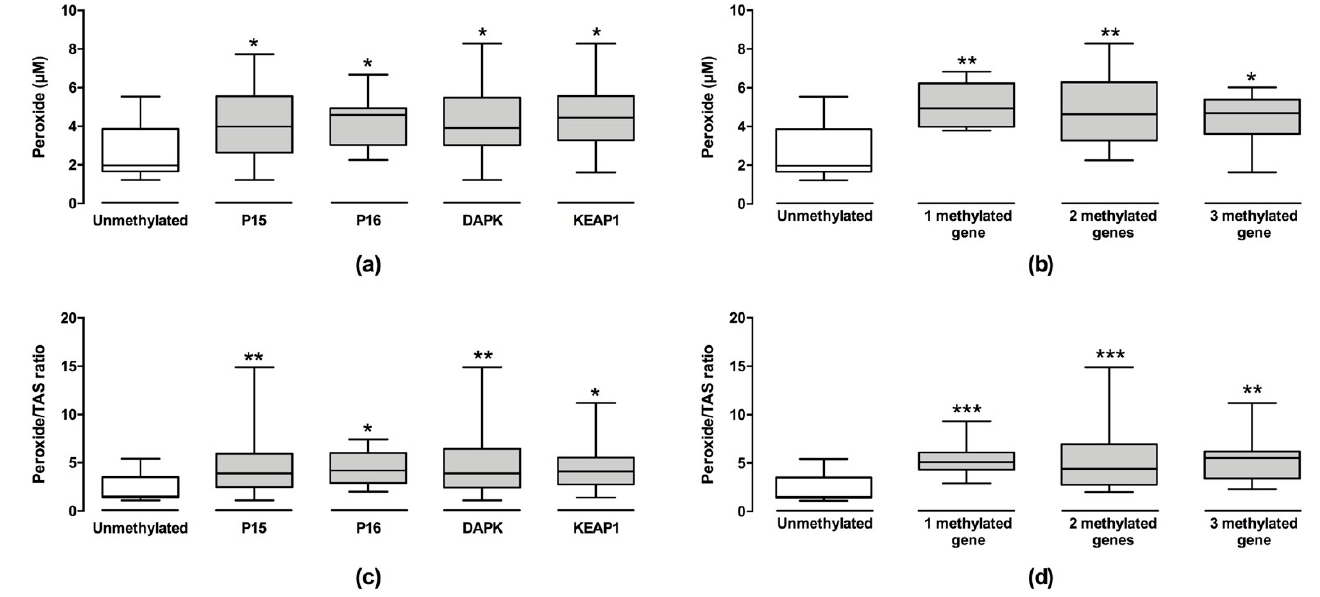
Figure 3. Analysis of oxidative stress parameters in myelodysplastic syndrome patients according to localized DNA methylation status ( a – d ). The levels of peroxides ( a ) and peroxides/TSA ( c ) were analyzed in patients stratified according to their methylation statuses of the P15, P16, DAPK, and KEAP1 genes. Next, the levels of peroxides ( b ) and peroxides/TSA ( d ) were examined in patients stratified according to the number of methylated genes. *, p < 0.050; **, p < 0.010; ***, p < 0.001.